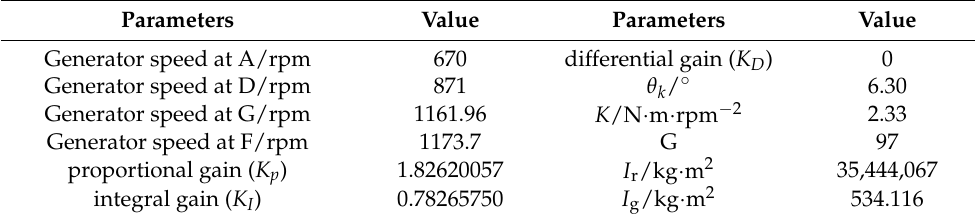
where θ represents the blade-pitch angle of the previous step, and θ k is a constant. The all utilized control parameters of the NREL 5 MW wind turbine are provided in Table 3. Table 3. The control parameters pertinent to the NREL 5 MW wind turbine. Parameters